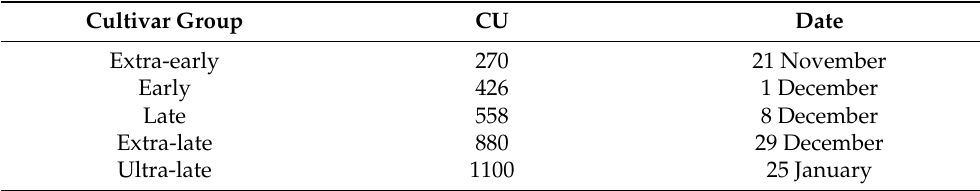
Table 1. Chill requirements (CU) for endodormancy release and the endodormancy release date for each cultivar